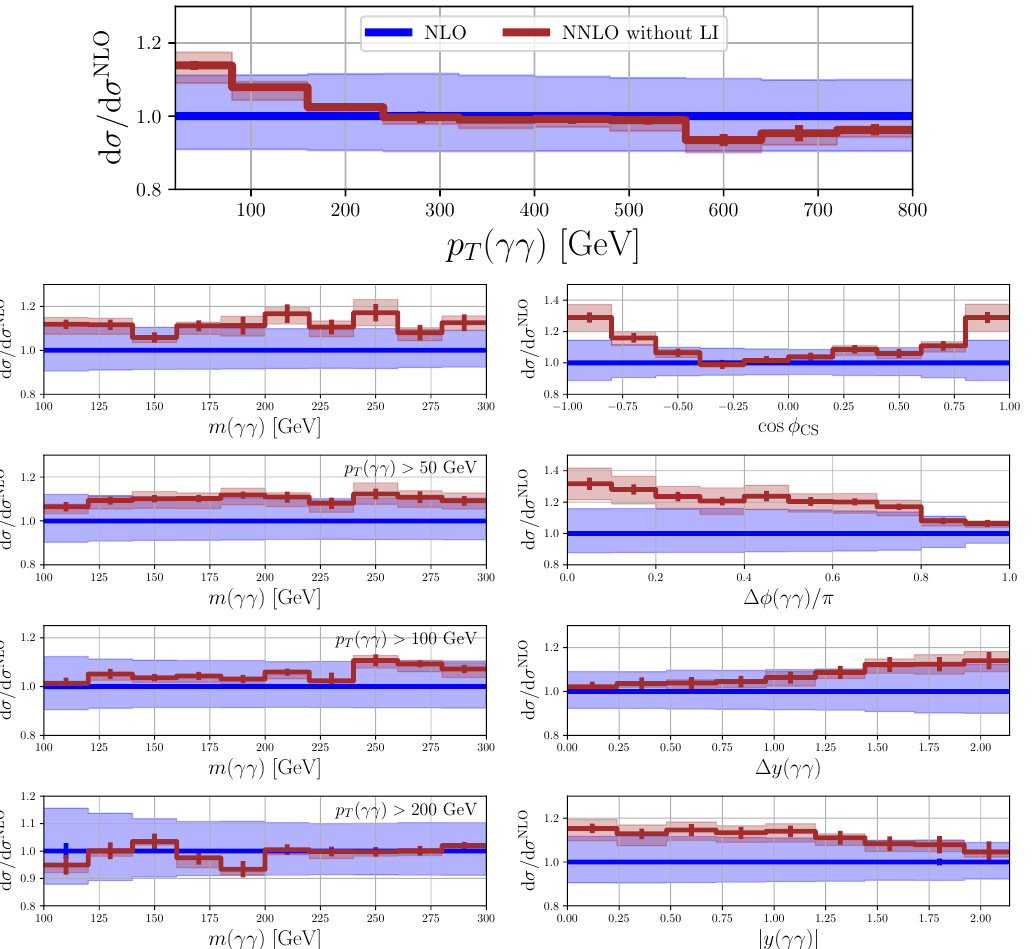
Figure 7 . Comparison of NLO (blue) scale bands to NNLO QCD excluding the loop-induced contribution (dark